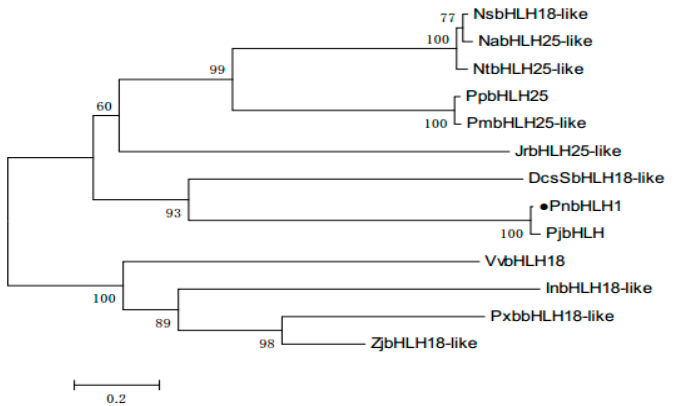
Figure 3. Phylogenetic analysis of PnbHLH1 protein sequences with other bHLH proteins. The